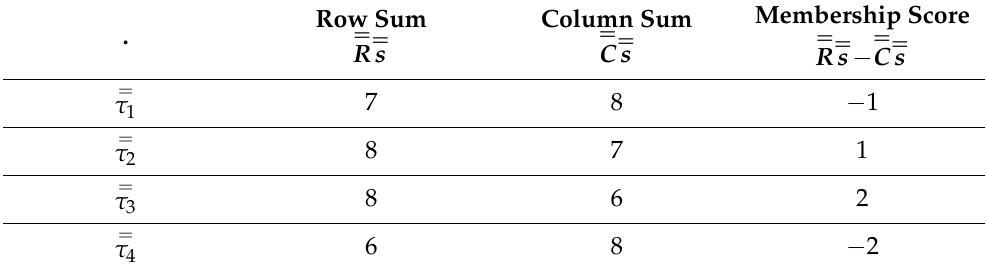
Table 9. NTG score table scenario 1.